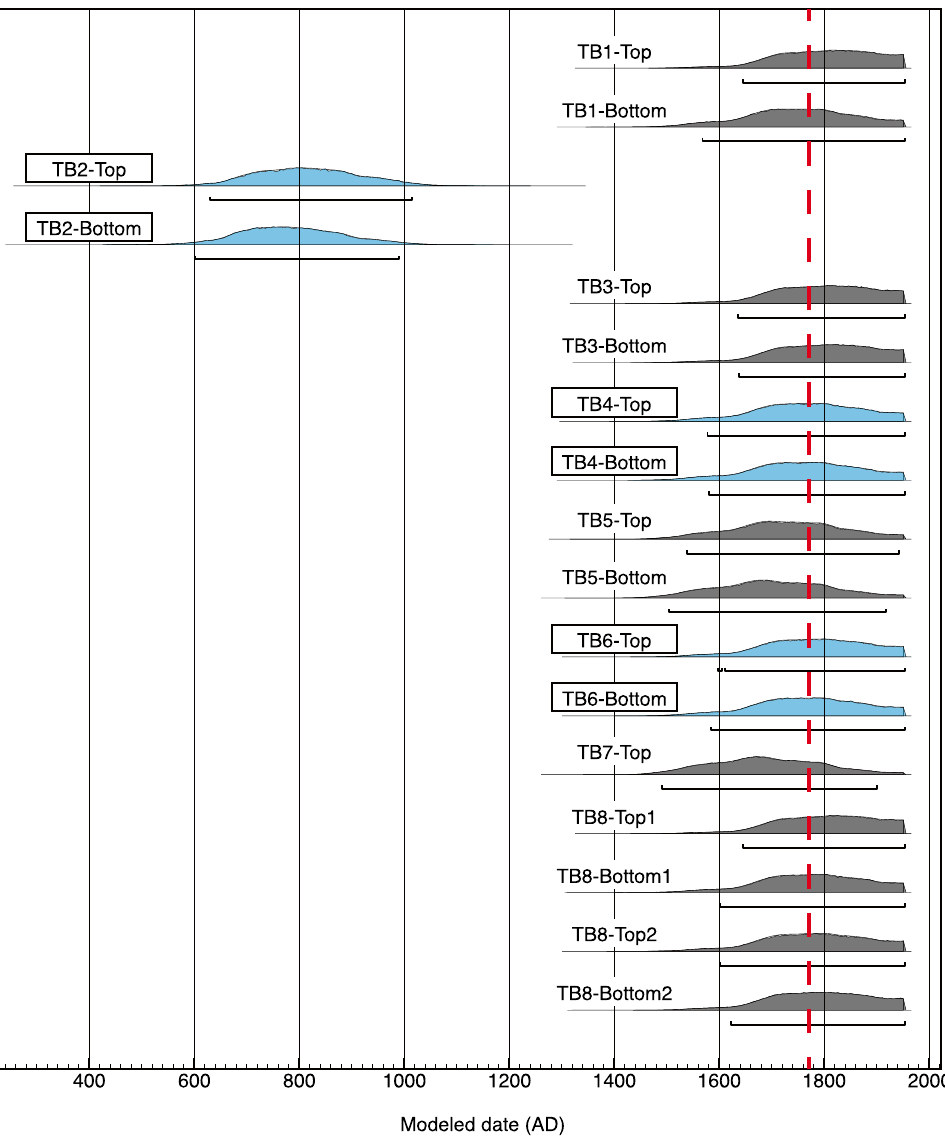
Figure 2. Calibrated 14 C ages of tsunami boulders. The horizontal black bars are the two-sigma age ranges of the samples. The red line shows the age of the Meiwa tsunami, while the blue color represents utilized thermal demagnetization data samples.